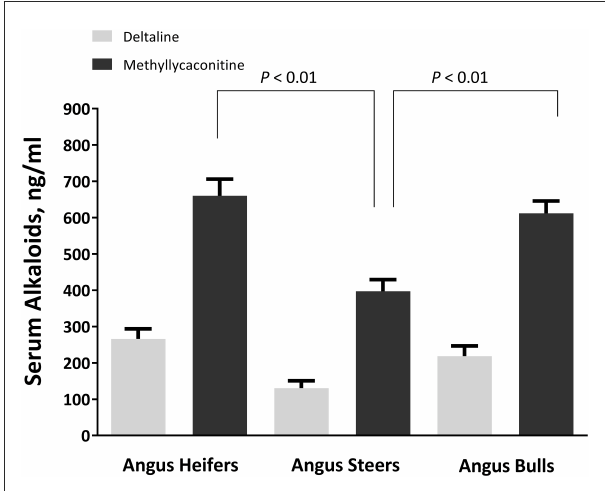
FIGURE4 Serum alkaloid concentrations in heifers, steers, and bulls. The serum concentrations of deltaline and methyllycaconitine (MLA) (ng/mL) in 30 heifers, 23 steers, and 33 bulls at 24h after oral dosing. Blood was collected at 24h after dosing just prior to exercise. Chemical analysis of serum methyllycaconitine, and deltaline was performed as previously described (47). Serum